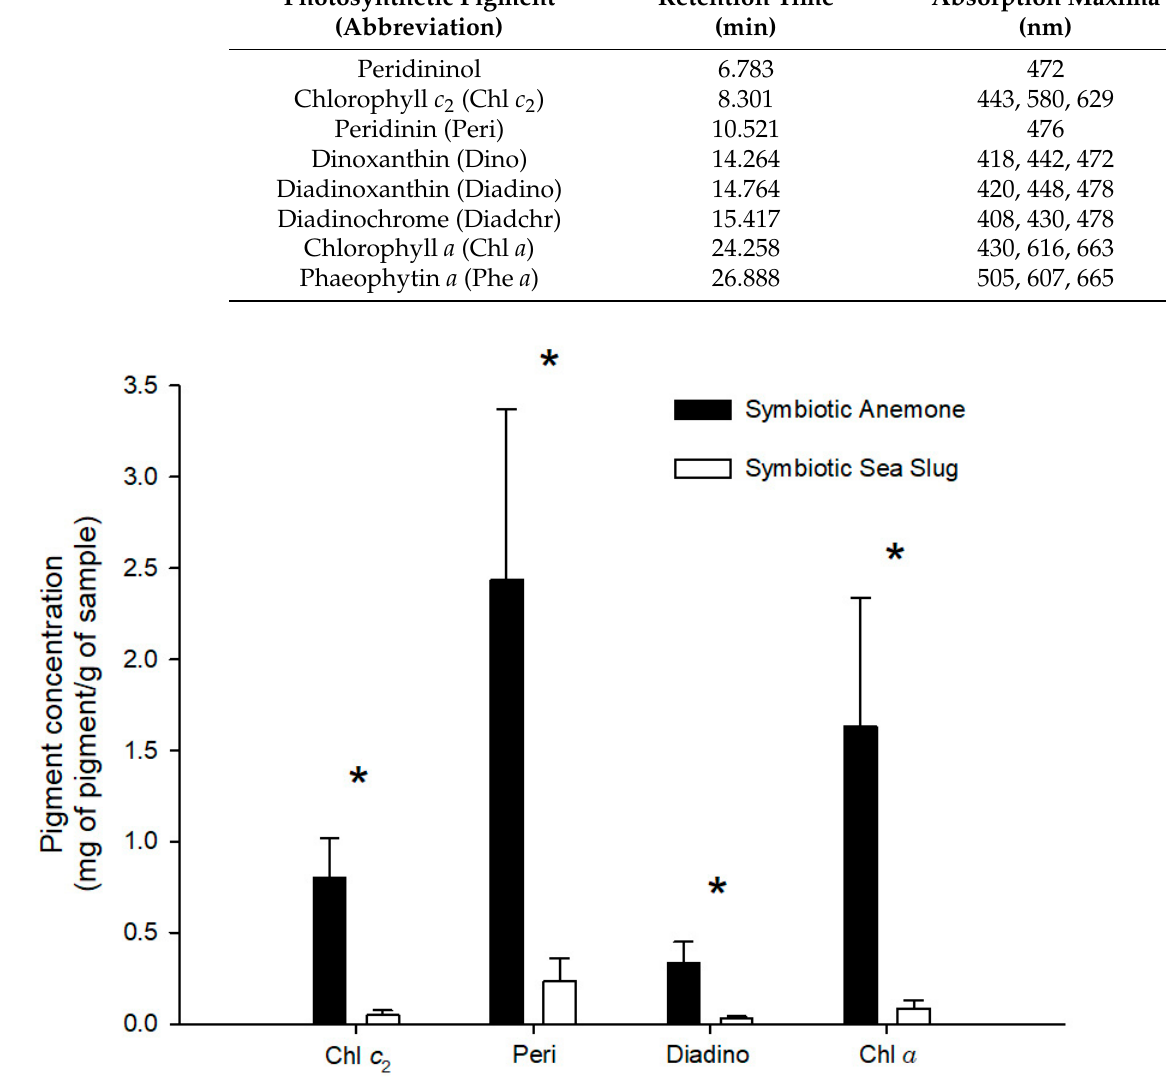
Figure 8. Concentration of photosynthetic pigments (mean ± std. error, n = 5) recorded in symbiotic anemones Exaiptasia diaphana and sea slugs Berghia stephanieae fed with symbiotic anemones ( Exaiptasia diaphana ). Chl c 2 —chlorophyll c 2 , Peri— peridinin, Diadino—diadinoxanthin, Chl a —chlorophyll a . An asterisk above a pigment indicates significant differences ( p <